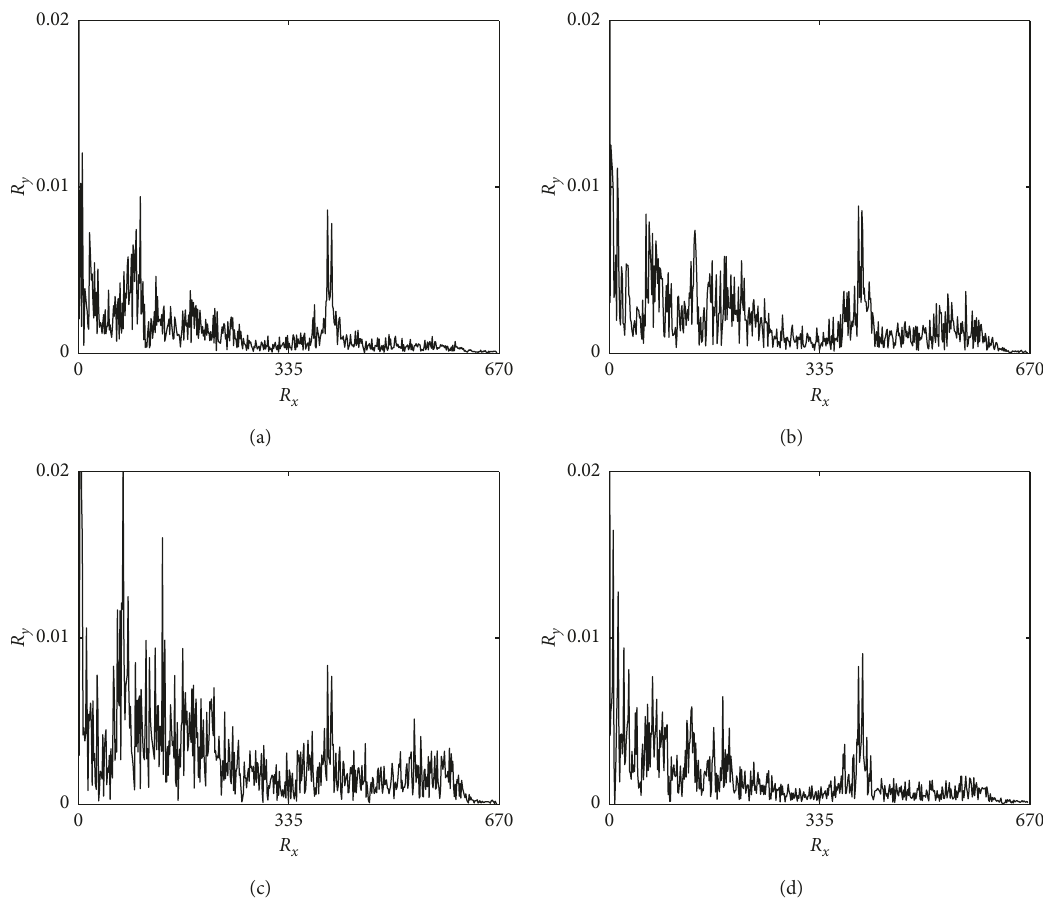
Figure 8: The adjusted spectrum images of dataset B: (a) NO; (b) IF; (c) OF; (d)